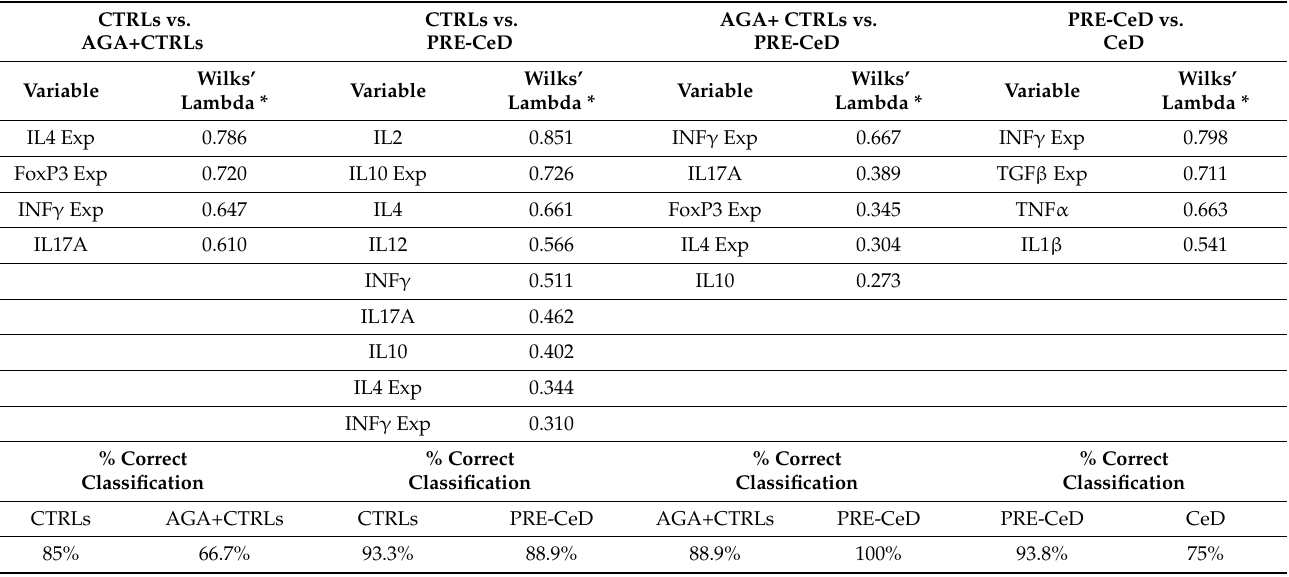
Table 2. Discriminant analysis based on serum cytokines and gene